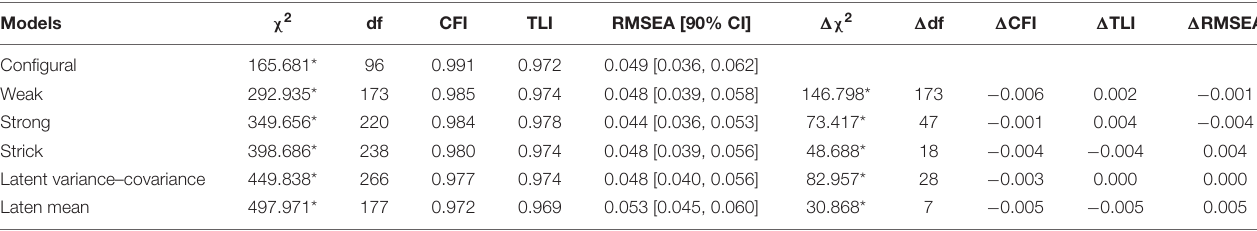
TABLE 4 | Tests of measurement invariance of the bifactor ESEM of the Japanese version of the State Self-Compassion Scale across sexes in Study 1.